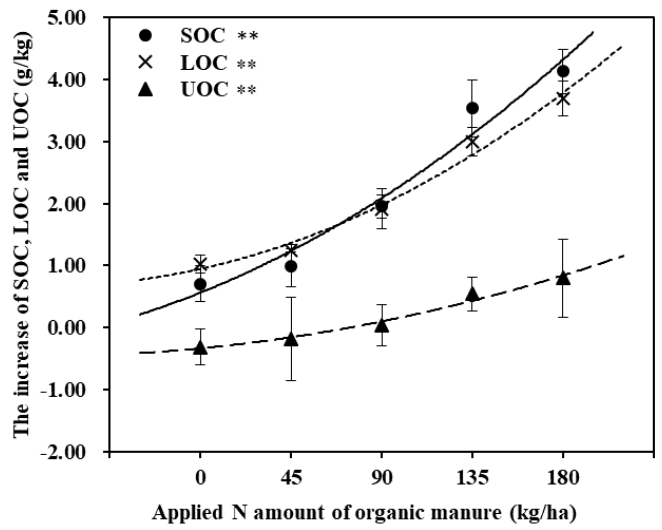
Figure 2. Linear regression analysis between increases in SOC, LOC, and UOC and amount of applied N. Values on the horizontal axis denote the amount of applied N in organic manure, and those on the vertical axis denote increases in SOC, LOC, and UOC vs. CK. The solid line and upper and lower dotted lines represents the regression lines for SOC, LOC, and UOC, respectively. ** p < 0.05.